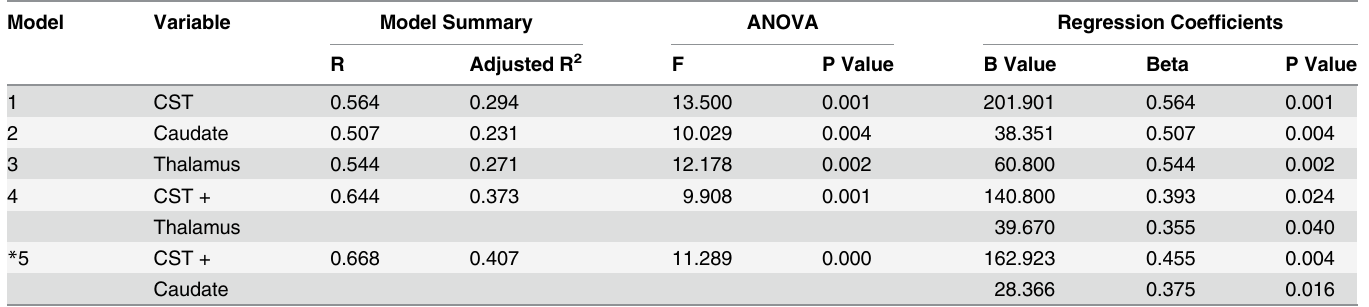
Table 4. Regression analysis of different independent